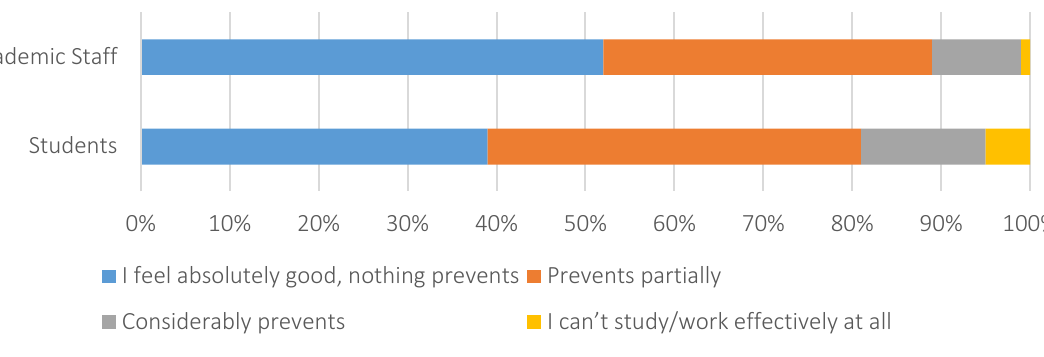
Figure 3. Psycho-emotional condition of the participants of the educational process at Kherson State University,